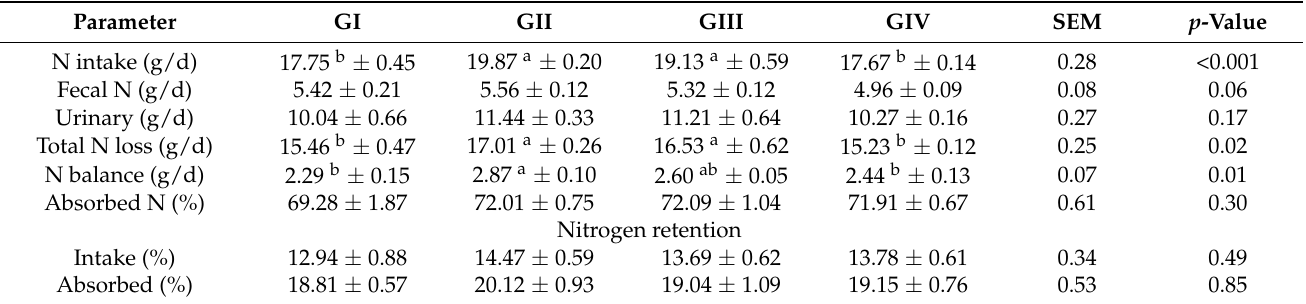
Table 5. N balance of experimental animals in different groups fed with replacement of concentrate with Moringa oleifera leaves: GI (control), GII (60R:40C with 10% of concentrate replaced with ML), GIII (70R:30C and 20% replacement of concentrate with ML), and GIV (80R:20C and 20% replacement of concentrate with ML).